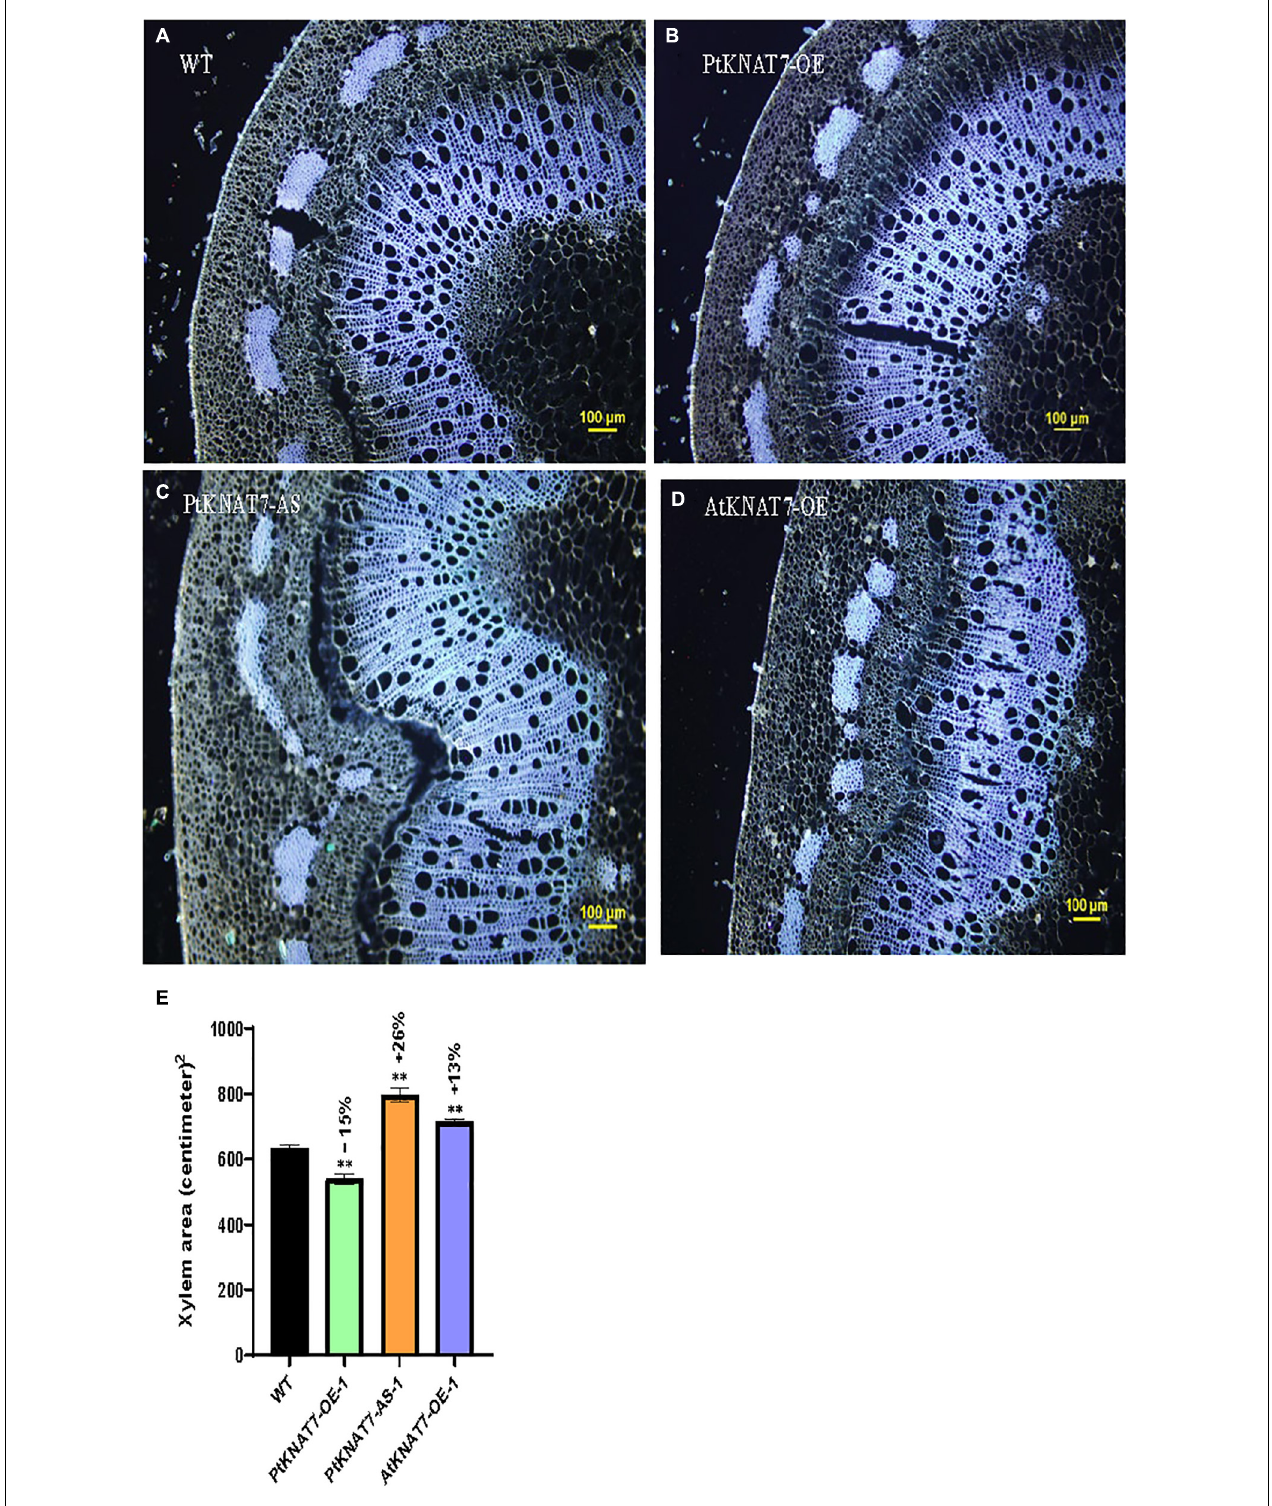
FIGURE 4 | Autofluorescence images of cross-sections and measurements of xylem area. Tissue sections for histological studies were performed at the 7th internode from the top. Cross-section of wild type (A) compared from PtKNAT7 -OE (B) , PtKNAT7 -AS (C) , AtKNAT7 -OE (D) , Scale bars-100 micrometers. (E) Xylem area measurements in WT and three KNAT7 transgenic lines in poplars. Significant differences were observed as compared to WT controls. Measurements were calculated from the xylem area observed at three separate points and averaged ( n = 3).